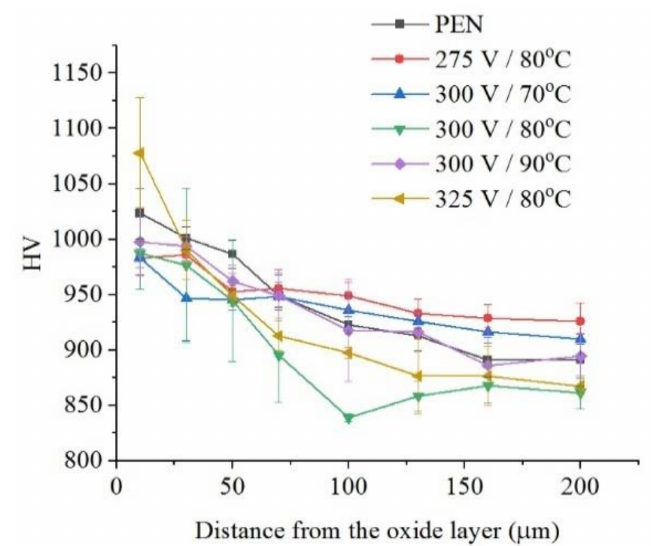
Figure 12. Distribution of microhardness in the surface layer of steel after PEN and subsequent PEP in ammonium sulfate (3%) solution under natural convection of electrolyte at different voltages and electrolyte